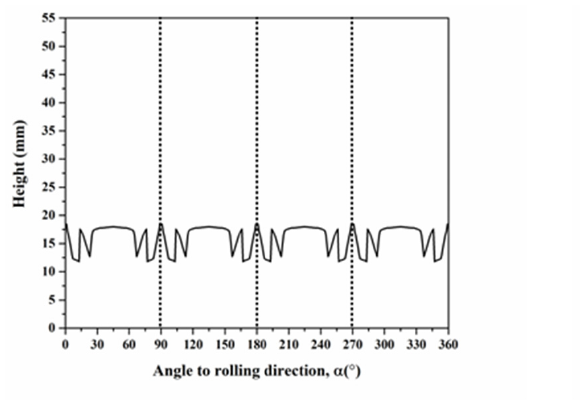
Figure 14. Cup height profiles as a function of the angle for texture components of ( a ) C, ( b ) S, ( c ) B, ( d ) Cube, ( e ) r-Cube, and ( f ) G considering the multi-slip systems.